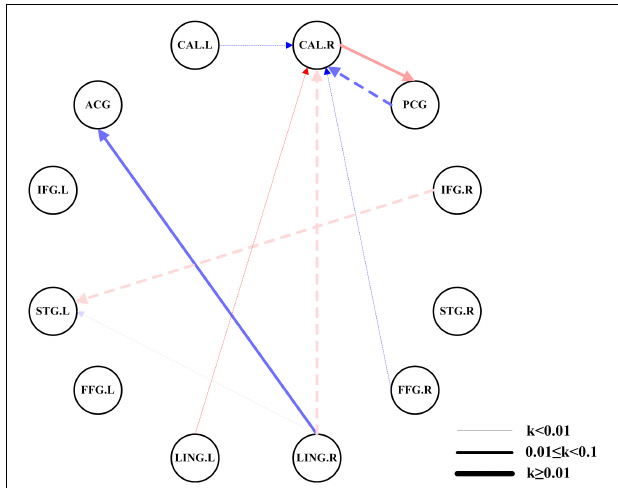
FIGURE 3 | Comparisons of EC networks between the two groups using ROI-wise EC. The color shades represent significance of EC (0 < P < 0.015, 0.015 ≤ P ≤ 0.03, and 0.03 < P ≤ 0.05); red represents excitation, blue represents inhibition, and the arrow indicates the direction of connection. The dotted line indicated a significantly reduced EC in patients with amblyopia. The solid line indicated a significantly increased EC in patients with amblyopia. The thickness of the line represents the connection strength (weak: k < 0.01, medium: 0.01 ≤ k < 0.1, strong: k ≥ 0.1). CAL.L, left calcarine fissure; CAL.R, right calcarine fissure; ACG, anterior cingulate gyrus; PCG, posterior cingulate gyrus; IFG.L, left inferior frontal gyrus; IFG.R, right inferior frontal gyrus; STG.L, left superior temporal gyrus; STG.R, right superior temporal gyrus; FFG.L, left fusiform gyrus; FFG.R, right fusiform gyrus; LING.L, left lingual gyrus; LING.R, right lingual